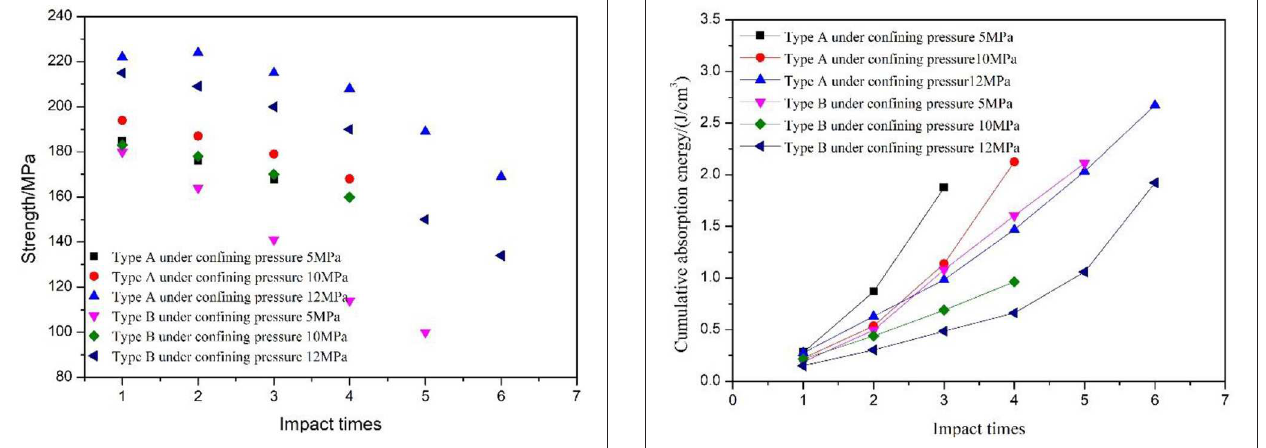
FIGURE 7 | Variation in dynamic strength with respect to impact times.